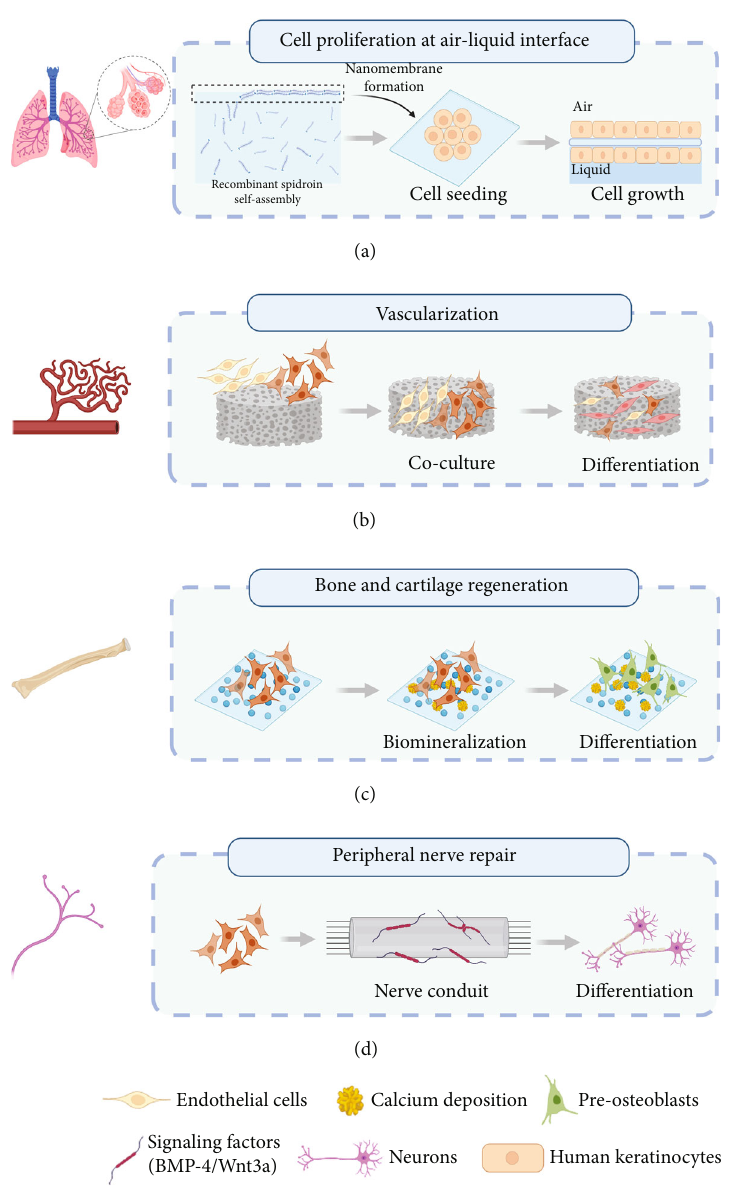
Figure 6: Schematic illustration of spidroin-based biomaterials for various tissue engineering applications. (a) For lung tissue engineering, FN-4RepCT silk protein forms a layer of nano fi brils via self-assembling at the liquid-air interface. The membrane enables the rapid formation of a con fl uent cell layer of human keratinocytes on either side. (b) For vascularization, the endothelial cells (ECs) and mesenchymal stem cells (MSCs) were cocultured on the recombinant spider silk (4RepCT) foams, and it was found that MSCs grew millimeter long branched sprouts in the foam within two weeks. (c) For bone and cartilage regeneration, the bone marrow mesenchymal stem cells (hMSCs) cultured on recombinant protein fi lms can promote osteogenic di ff erentiation by enhancing biomineralization. (d) For peripheral nerve repair, the neural stem cells (NSCs) cultured on the 4RepCT matrices di ff erentiated e ffi ciently into neurons after processing the recombinant protein including the extracellular signaling factor BMP4 or a combination of BMP4 and the signaling factor